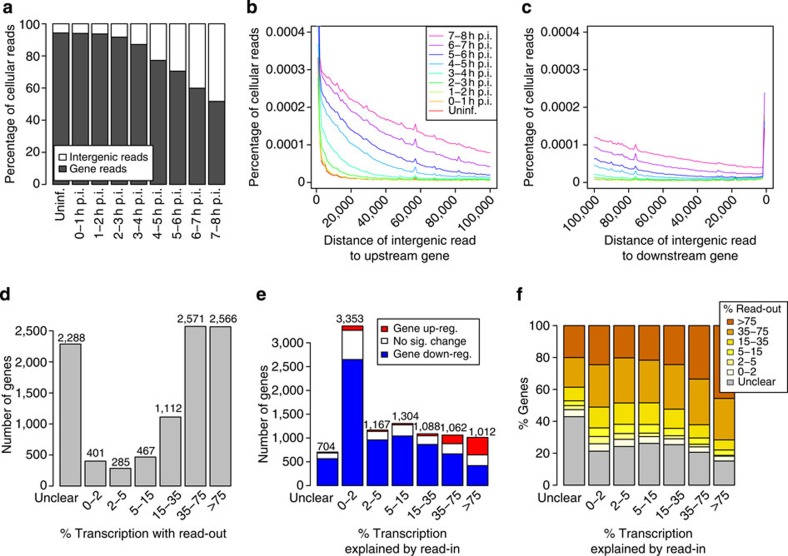
Lytic HSV-1 infection disrupts transcription termination.(a) The proportion of 4sU-RNA reads mapping to human genes and intergenic regions illustrates the dramatic increase in intergenic transcription during HSV-1 infection. (b,c) Distribution of intergenic reads down- (b) and upstream (c) of genes demonstrates that intergenic transcription peaks at gene 3′-ends and gradually declines with increasing distance from 3′-ends. Only reads within intergenic regions with length ⩾100,000 nt were considered and read counts were determined in 1,000 nt windows downstream of gene 3′-ends and upstream of gene 5′-ends. (d) Number of genes with various extents of read-out. Extent of read-out at late times of infection was quantified as % transcription with read-out (=100 × RPKM within the first 5,000 nt downstream of the gene/gene RPKM) at 7–8 h p.i. Read-out (and read-in) was classified as unclear if it was larger than 5% but without significant correlation between downstream (upstream) expression and the course of infection. (e) Number of genes with various extents of read-in. Extent of read-in was quantified as % transcription explained by read-in (=100 × RPKM in the first 5,000 nt upstream of the gene/gene RPKM) at 7–8 h p.i. Genes with a high extent of read-in were enriched for upregulated genes (⩾2-fold, see Methods). (f) Combined analysis of the extent of read-out and read-in at 7–8 h p.i. Genes with high extent of read-in were also enriched for read-out, that is, even a second poly(A) signal was often not sufficient to terminate transcription.